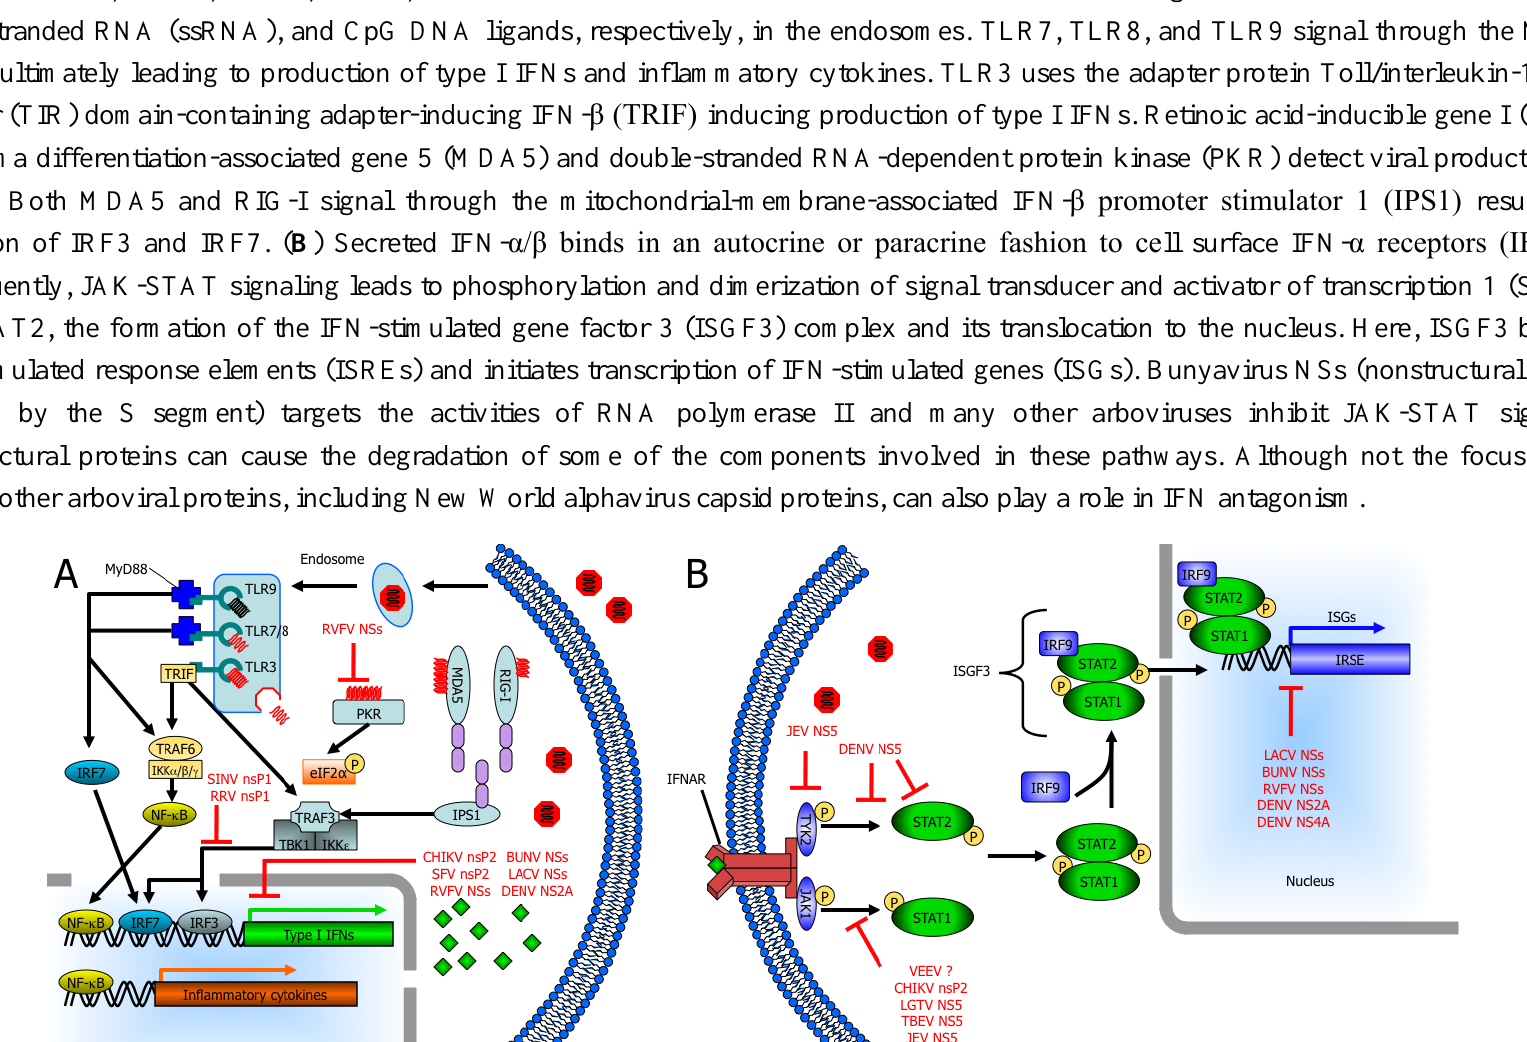
Figure 1. Arbovirus nonstructural proteins use several mechanisms to disrupt IFN induction and signaling. ( A ) The Toll-like receptor (TLR) family members, TLR3, TLR7, TLR8, and TLR9 are located in endosomal membranes sensing double-stranded RNA